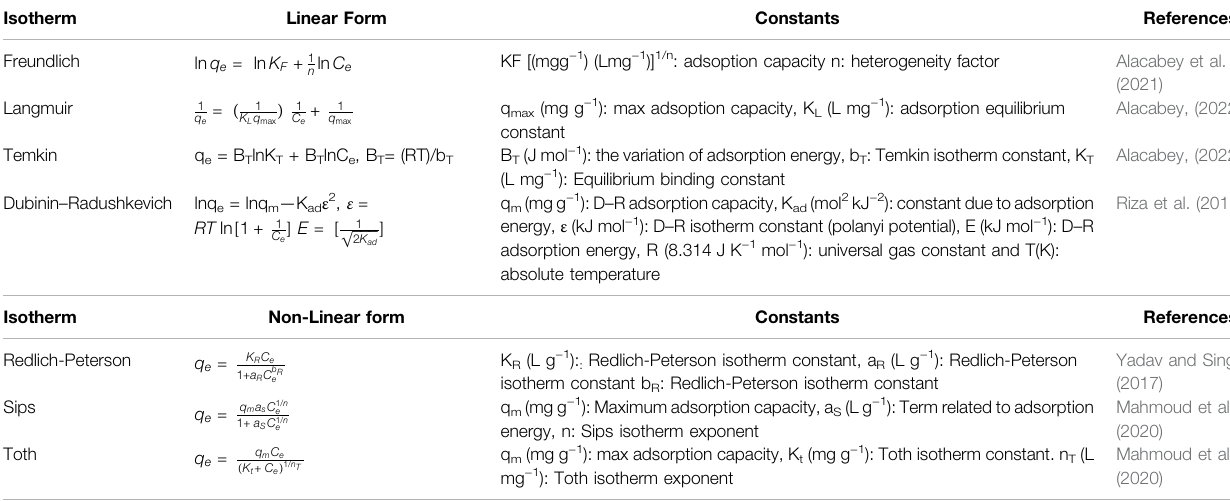
TABLE 1 | Linear adsorption isotherms and Non-Linear adsorption